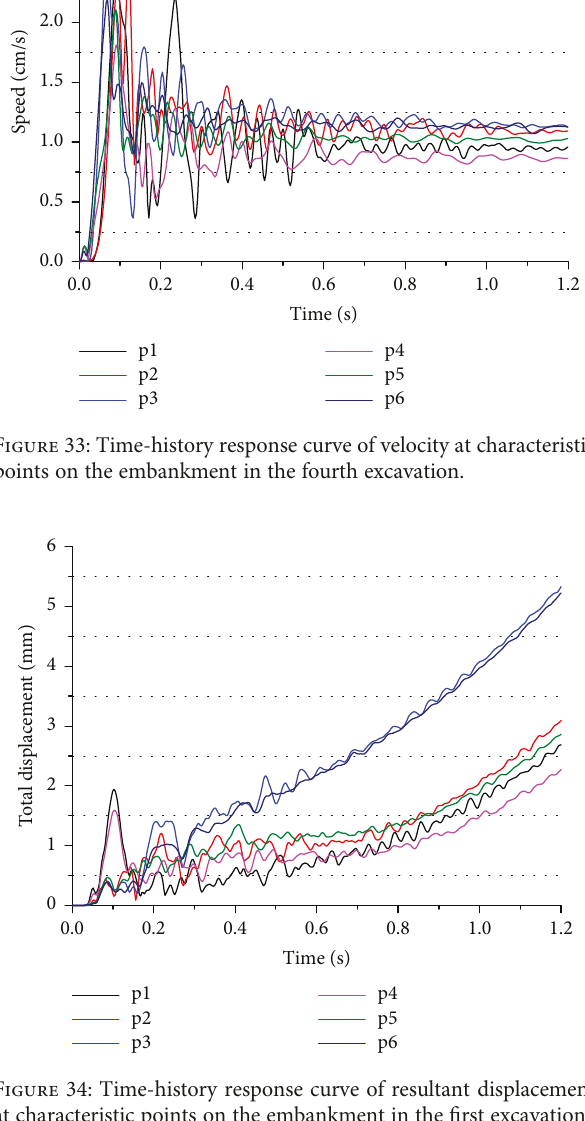
Figure 36: Time-history response curve of resultant displacement at characteristic points on the embankment in the third